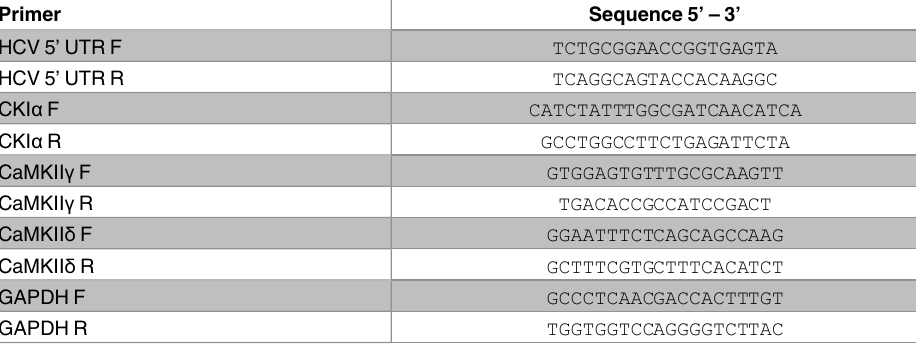
Table 1. Primers used for quantitative RT-PCR